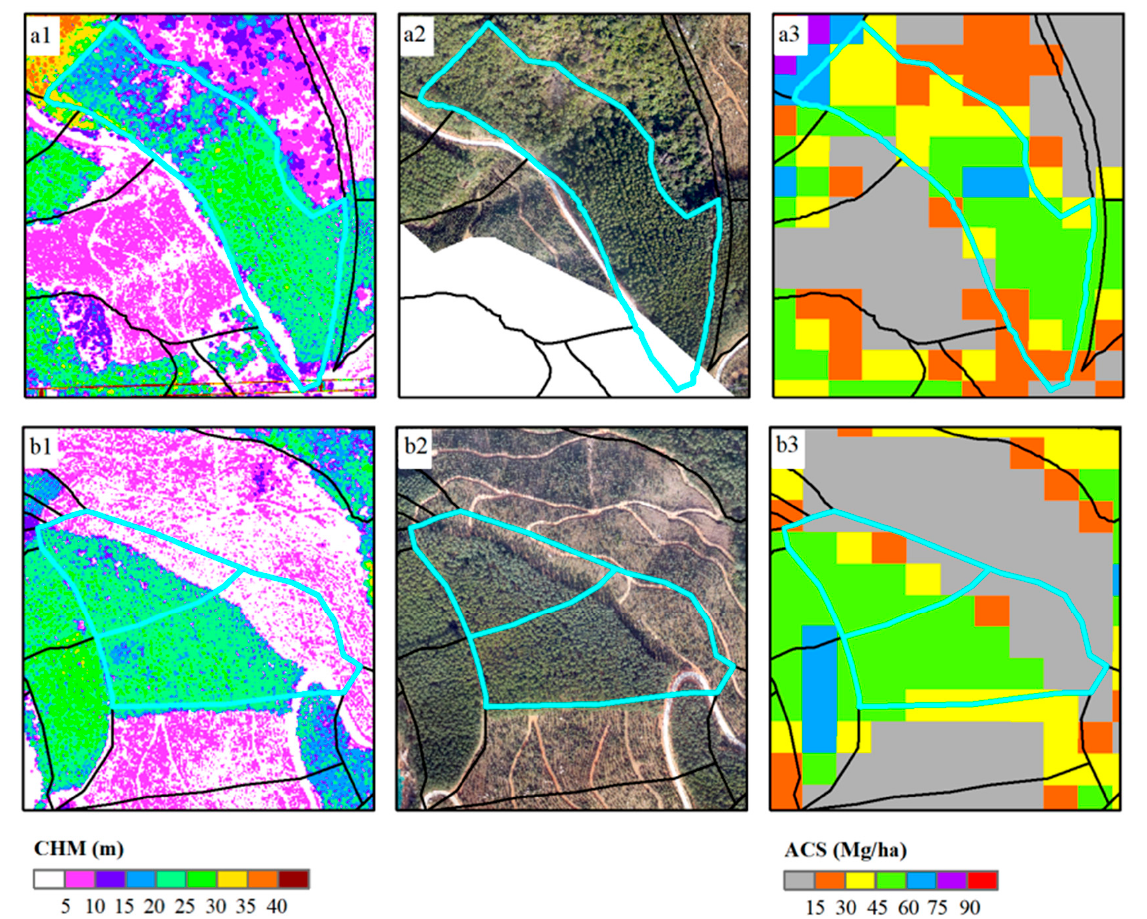
Figure 9. Spatial heterogeneity in FSC. Plots ( a1 , b1 ) are CHM; ( a2 , b2 ) are aerial photo; ( a3 , b3 ) are aboveground carbon stocks (ACS) estimated by UAV lidar data with the spatial resolution of 20 m.